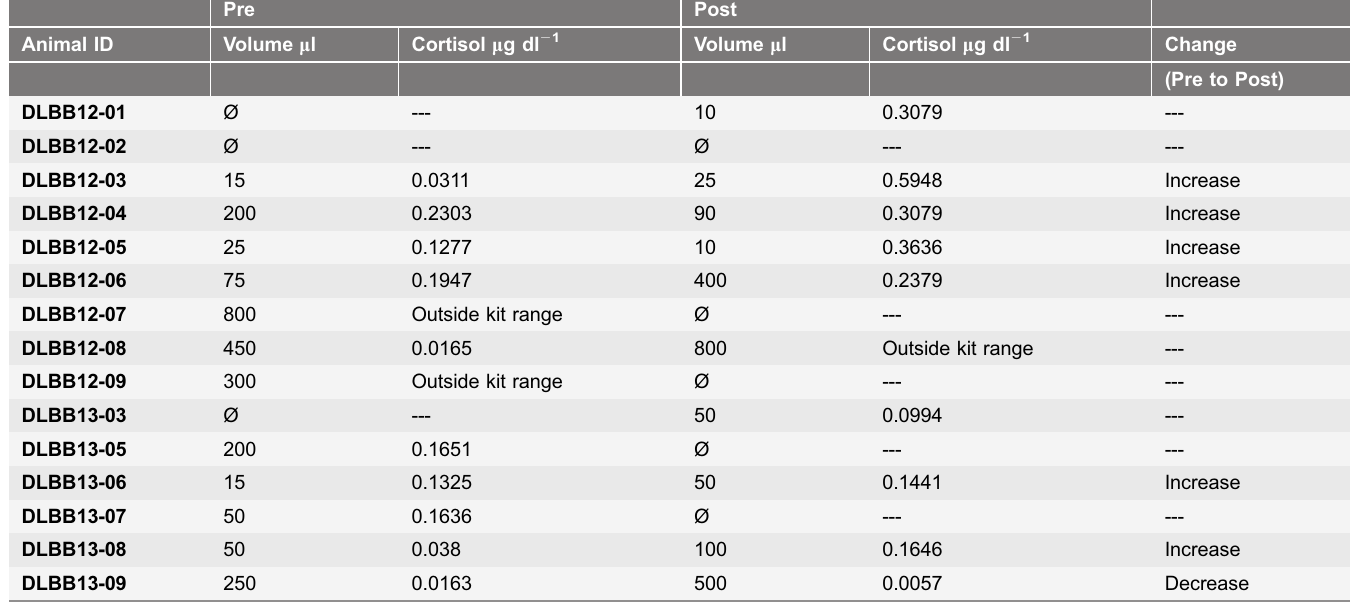
Ø indicates no sample recovered from